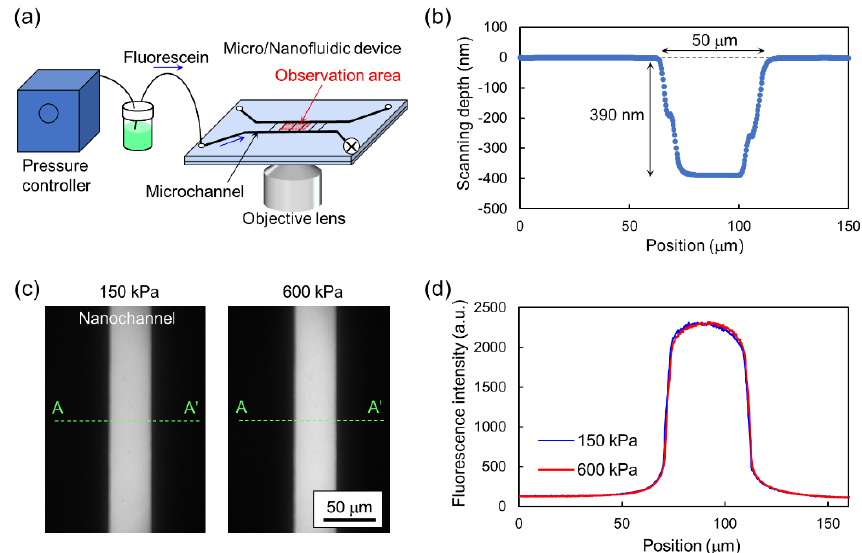
Figure 7. Examination of the pressure resistance of a micro / nanofluidic device by fluorescence microscopy. ( a ) Experimental setup. ( b ) Cross-sectional profile of a nanochannel measured by stylus surface profiler. ( c ) Fluorescence images of nanochannel where fluorescein solution was injected by external pressure. ( d ) Profiles of fluorescent intensity in transverse direction of nanochannel (A-A’).